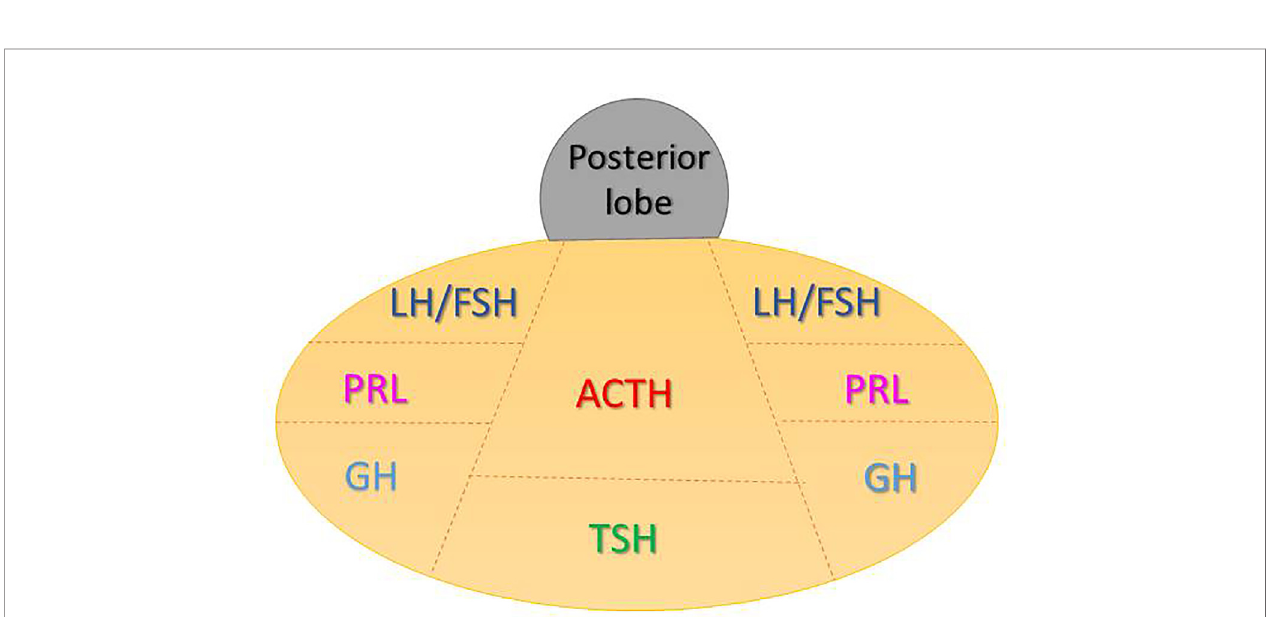
FIGURE 3 | Distribution of anterior pituitary cell